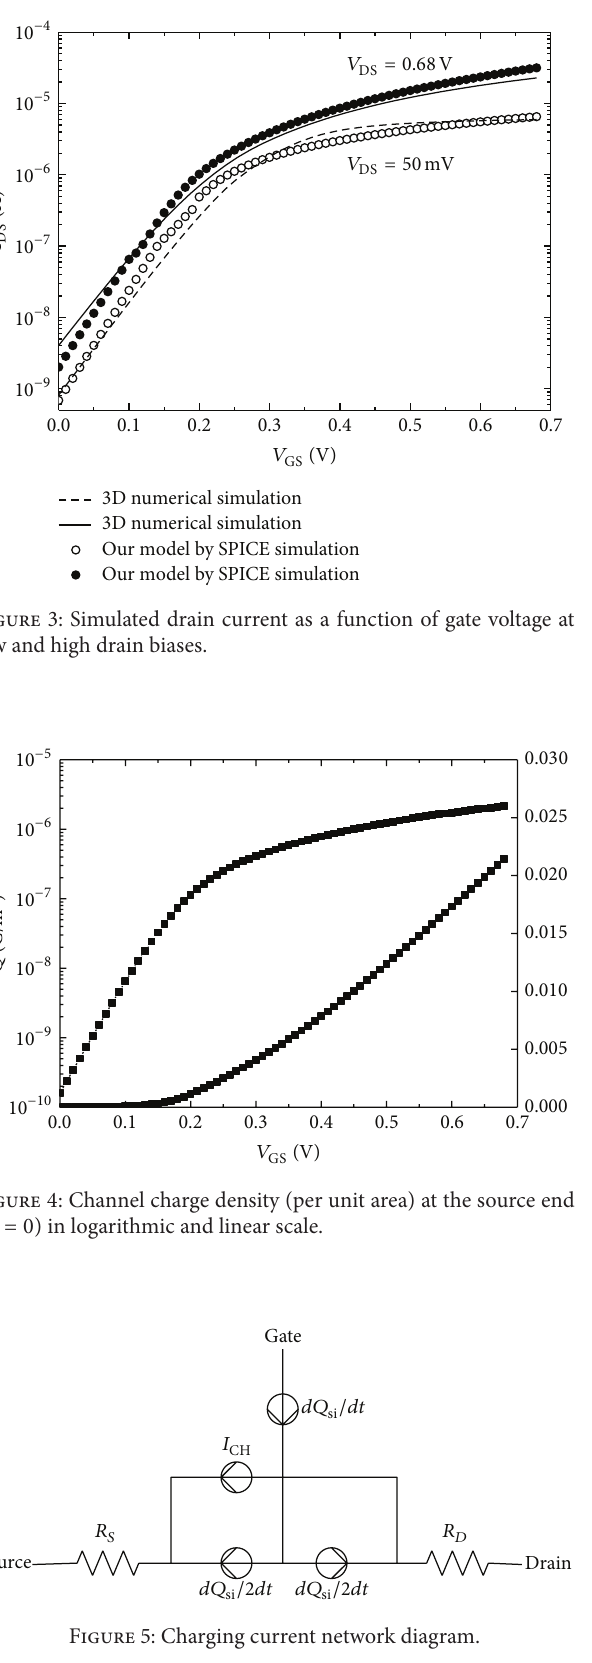
Figure 8: Transient simulated inverter